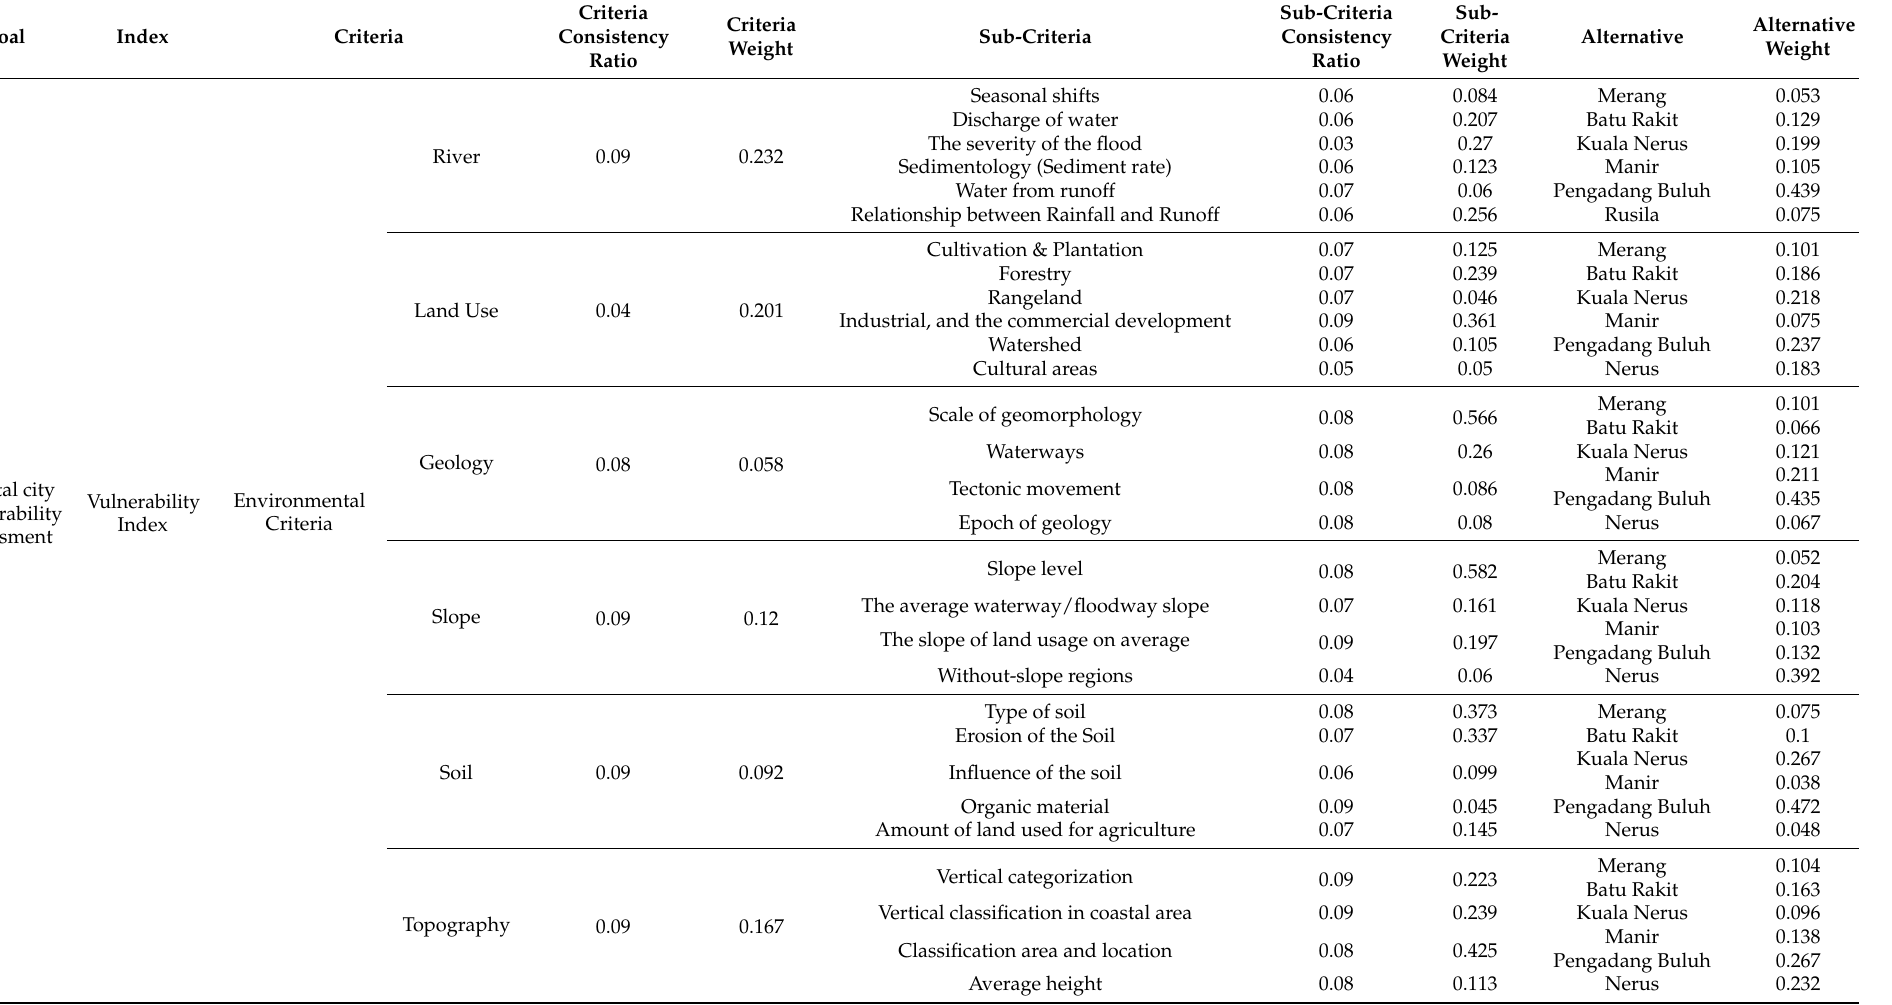
Table 2. Delphi-AHP weights for coastal city vulnerability criteria for Kuala Terengganu,